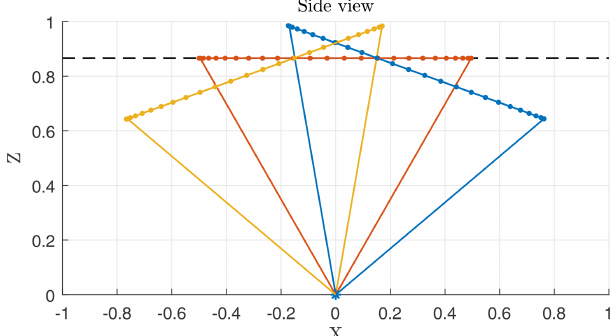
Figure 2. Measurement cone under influence of static or slowly changing pitch angle of A = 20 ◦ with maximum positive (blue), zero (red), and maximum negative elongation (yellow). Only up- and downwind beams are depicted as lines; for other beams fo- cus locations are given by dot markers along a measurement circle. Nominal measurement elevation is shown (black dashed